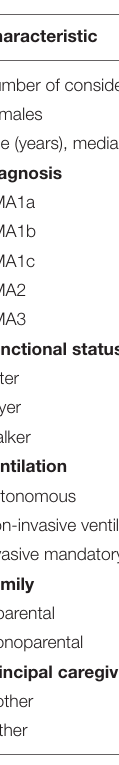
TABLE 1 | Baseline characteristics of